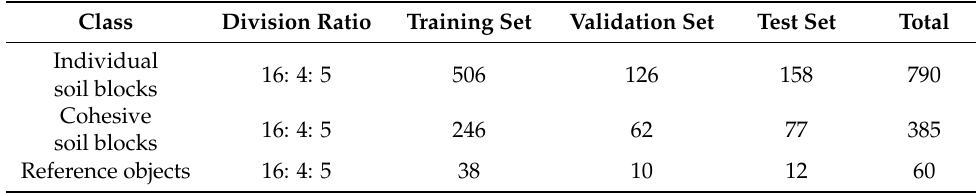
Table 1. Dataset distribution.